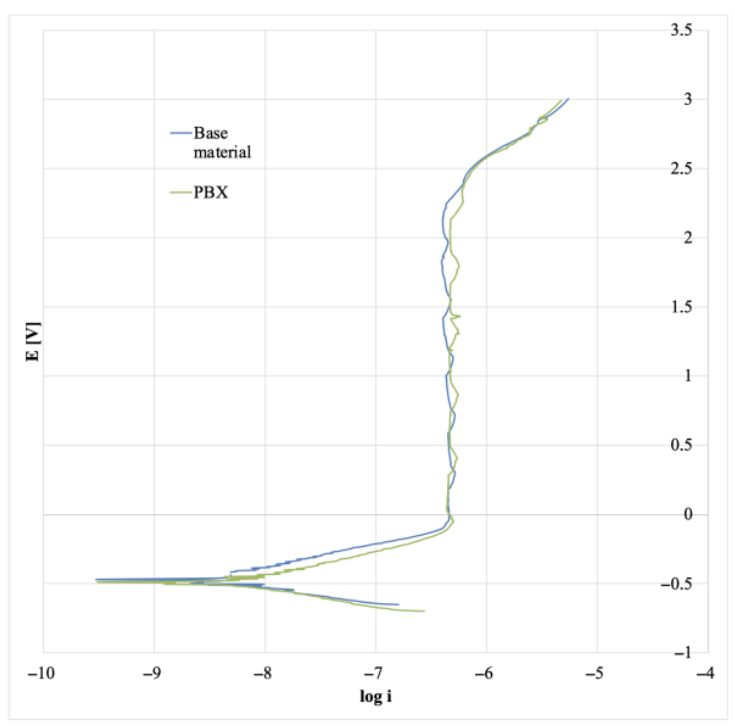
Figure 16. Summary plot for polarization curves for all samples.